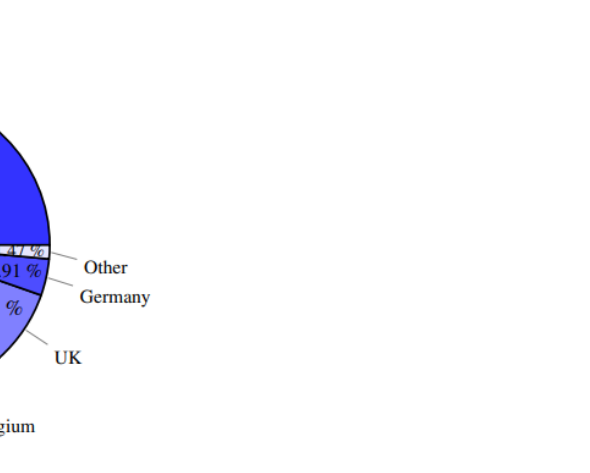
Figure 5. Global new offshore wind installations in 2020–by country (adapted with permission from Ref. from [45]). 2020, GWEC.).